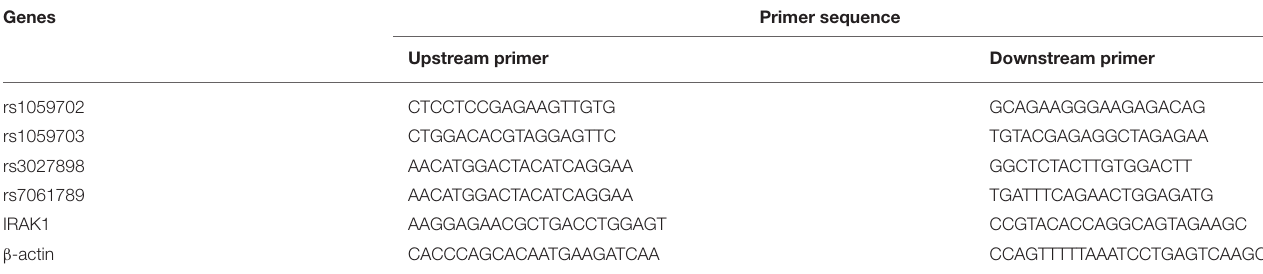
TABLE 1 | Primer information.